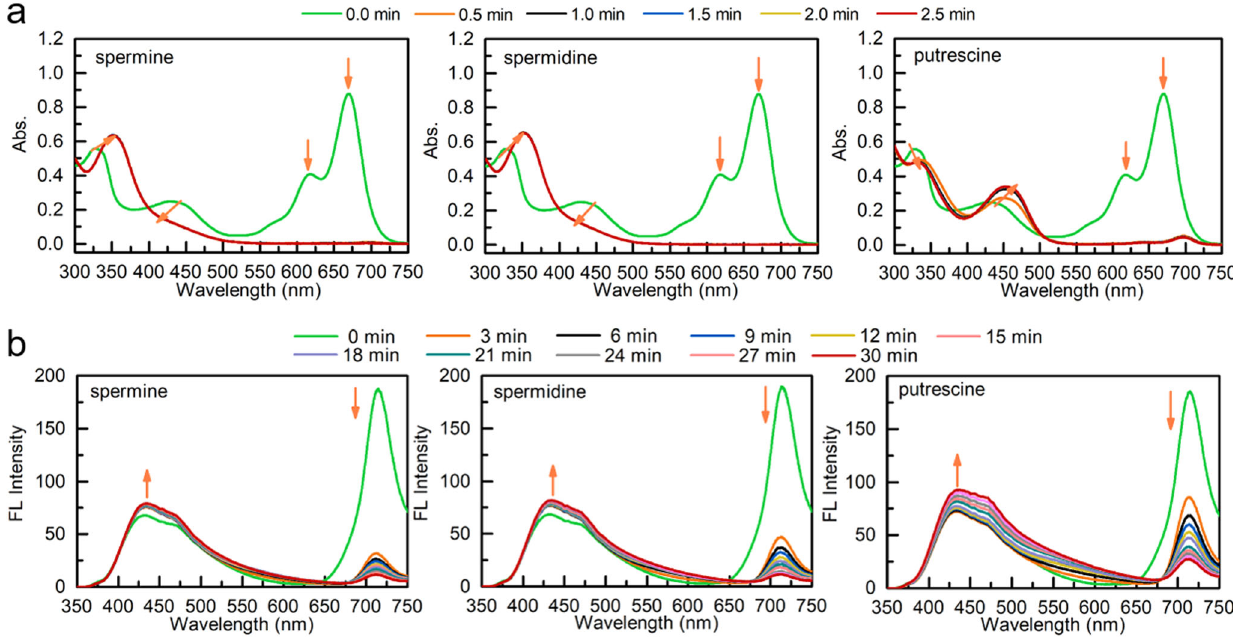
Fig. 2 The reactivity of PPAB-PyS with polyamines. Time-dependent a UV – vis and b emission spectra of PPAB-PyS (10 μ M) in MeCN in presence of spermine spermidine putrescine at and NMR spectrometry. The HRMS spectra in Supplementary Fig. 10 indicated the fi nal products ( DPP-PyS and two hetero- aromatic amines 2 and 3 ) were present by the peaks at 726.1 for [ DPP-PyS − 2H] + , 191.1 for [ 2 + H] + , 402.5 for [ 3 − 2H] + . Two